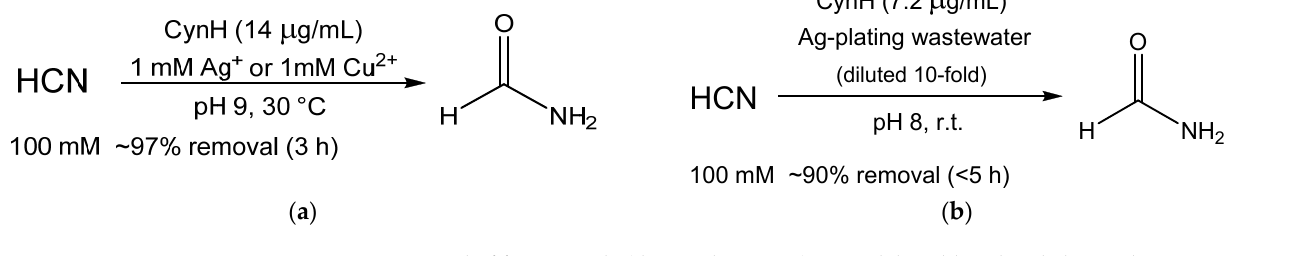
Figure 7. Removal of free cyanide (depicted as HCN) in model or diluted real electroplating wastewaters by cyanide hydratases (CynHs) overproduced in Escherichia coli . ( a ) The model wastewater was 100 mM glycine/NaOH buffer at pH = 9.0, supplemented with 100 mM KCN and 1 mM of AgNO 3 or 1 mM CuSO 4 . Conversion of HCN was catalyzed by the purified CynH from Exidia glandulosa [30]. ( b ) An electroplating bath wastewater with ca. 1 M fCN was 10 times diluted with 1 M MOPS buffer at pH = 8.0. Conversion of HCN was catalyzed by the purified CynH from Neurospora crassa [27]. The Cu or Ag content was not specified. r.t., room temperature.